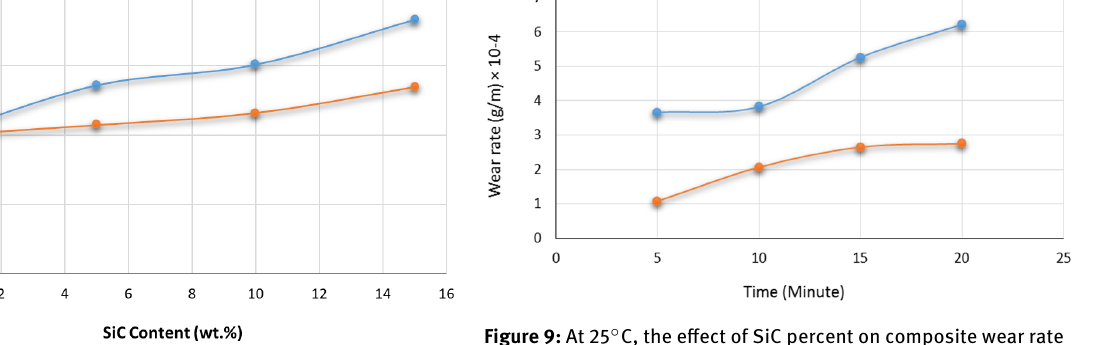
Figure 9: At 25 ∘ C, the effect of SiC percent on composite wear rate was investigated using a) a load of 10N and b) a rotational speed of 220 rpm